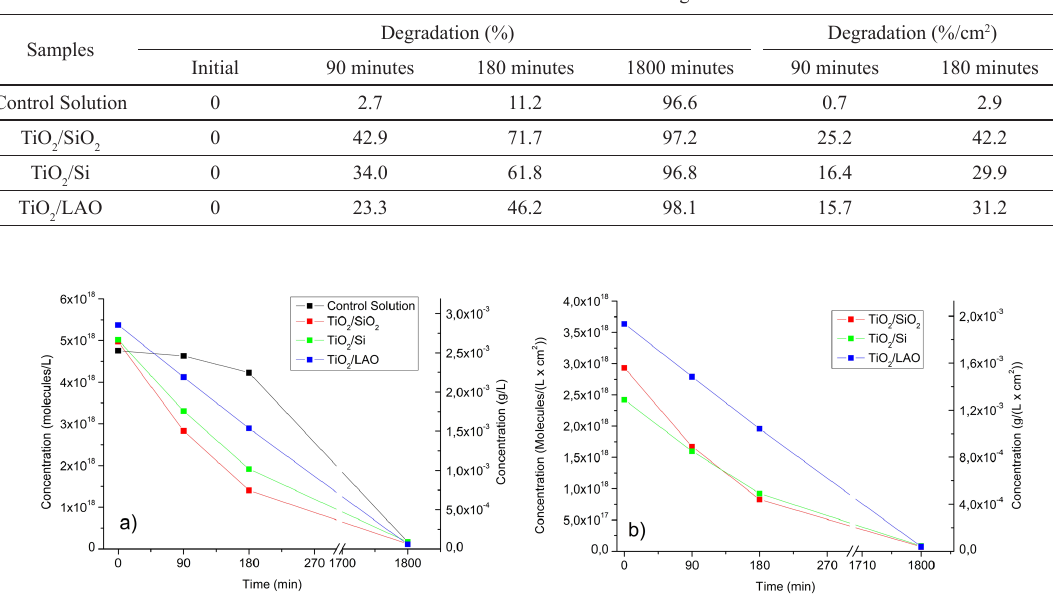
Figure 2. (a) Concentration in molecules/L and g/L up to 1800 minutes in the 13 th cycle of the photocatalytic test comparing three different substrates and the result of photodegradation of methylene blue without a photocatalyst in the same interval of time. (b) Concentration in molecules/(L x cm 2 ) and g/(L x cm 2 ) up to 1800 minutes in the 13 th cycle of the photocatalytic test comparing three different substrates. The areas of the films were 1.70 cm 2 in the silica substrate, while in silicon the value was 2.07 cm 2 and in lanthanum aluminate, the area was 1.48 cm 2 . The results correspond to UV irradiation of a mercury lamp, delivering 4.7 mW/cm 2 at the reactor position.